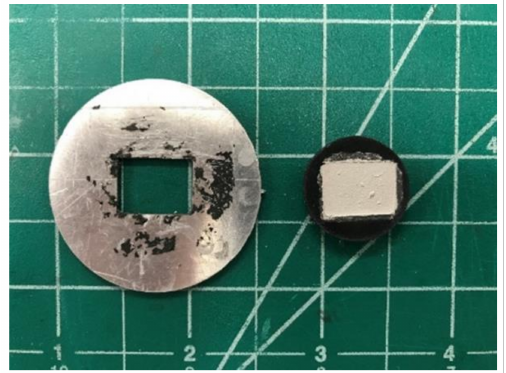
Figure 5. MPA mold ( left ) and PDC substrate ( right ) with conductive trace applied.